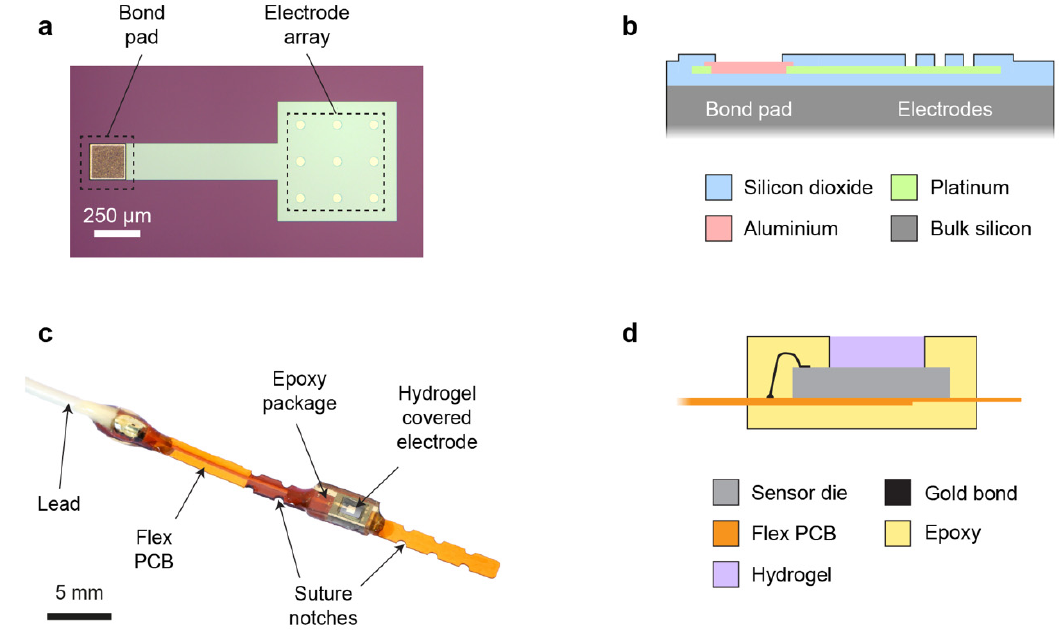
Figure 1. Sensor design and fabrication. ( a ): Microscope image of the 3 × 3 microelectrode WE array fabricated on a silicon substrate. The light-coloured circles in the passivation correspond to the active electrode areas. Platinum extends under all the electrodes, and it forms an interconnect track to left of the array. ( b ): Schematic cross-section of sensor die layer stack (not to scale), showing the aluminium bond pad, interconnect, and passivation windows over platinum electrodes. ( c ): Photograph of a fully packaged sensor, flexible PCB, and connection lead. ( d ): Schematic cross-section of the sensor epoxy packaging and pHEMA hydrogel membrane (not to scale). Reproduced with permission from [15].